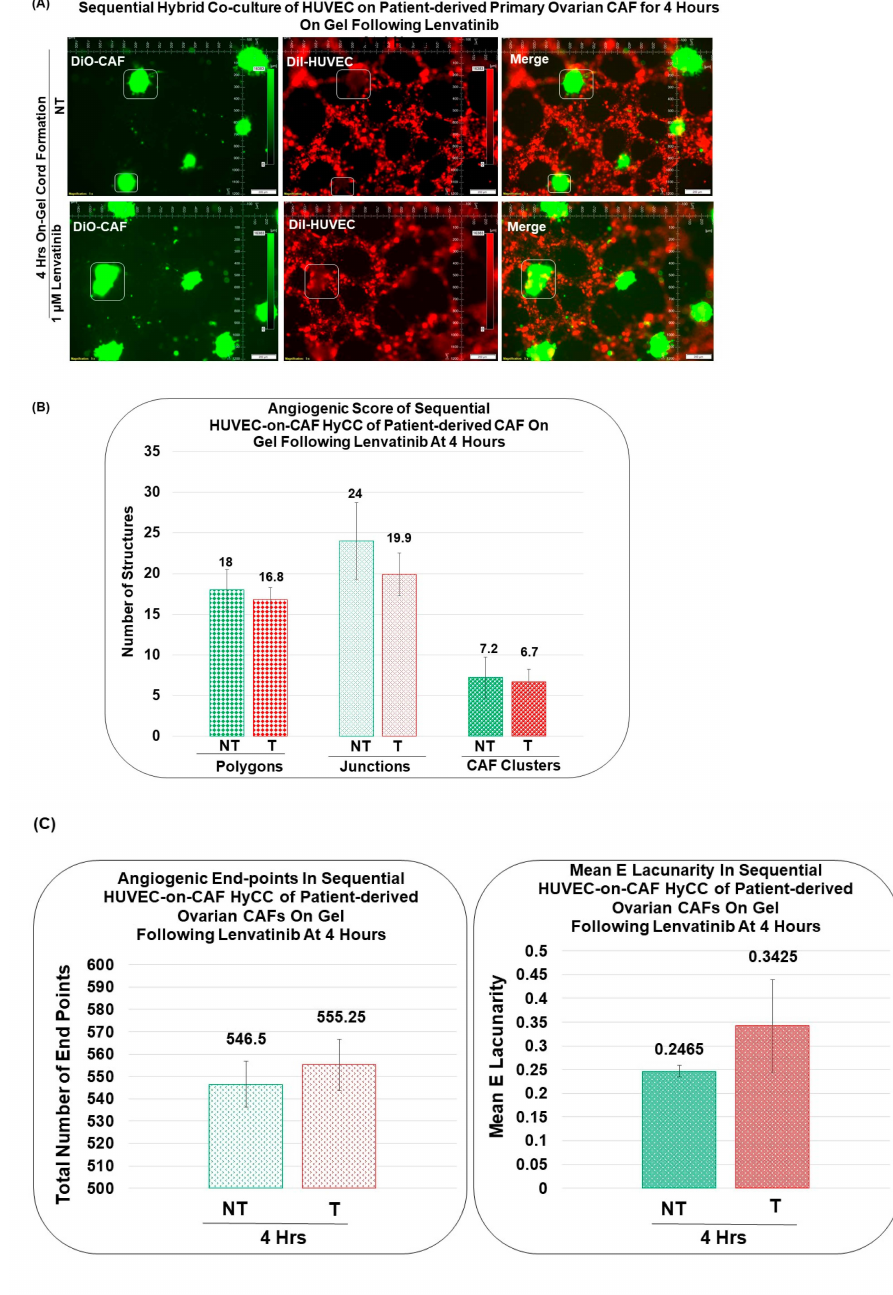
Figure 7. Effect of Lenvatinib on ex vivo on − gel sequential hybrid co − culture of HUVEC on Patient − Derived primary ovarian CAF for 4 h: We performed sequential Hybrid Co-Culture of HUVEC on Patient-Derived primary ovarian CAF for 4 h on-gel following lenvatinib ( A ). An- giogenic Scores ( B ) are determined by the polygons, junctions, and CAF clusters (as represented by rectangular/square boxes in photomicrographs of A) as well as angiogenic endpoints and mean E lacunarity ( C ). Matrigel tube formation assay of HUVECs cultured in HyCC format with patient-derived ovarian CAFs in control medium (green) or in the presence of 1 microM of lenva- tinib (red) for 4 h. Angiogenic Endpoints (total number) (represented in Divot bars) and the mean E lacunarity (represented in 40% filled bars) were detected with the AngioTool software (https://ccrod.cancer.gov/confluence/display/ROB2/Home [(accessed on 9 August 2022)]). Bars represent the mean and standard deviation of the